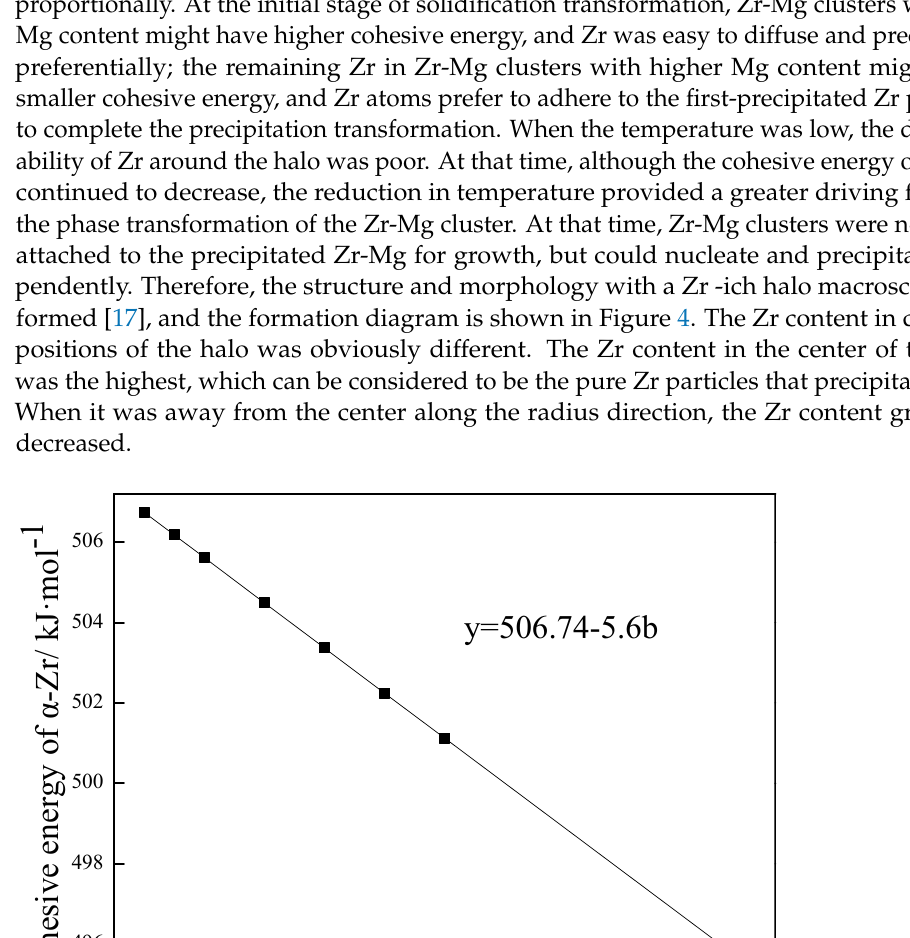
( c ) Figure 4. Schematic diagram of the formation of Zr-enriched halo structure in Mg–Zr alloy during solidification process ( a ) initial stage ( b ) intermediate stage ( c ) final stage. Through the previous analysis, we can conclude that it was precisely because of the formation of this special halo structure in the precipitation process that some Zr particles can become an effective heterogeneous nucleus of α -Mg. In the microstructure, this struc- ture of halo should be similar to the morphology of the double nucleation in an Al–Ti–B refiner, i.e., the two dimensional Al–Ti atomic layer was wrapped on the surface of TiB 2 particles. Generally, the structure and composition of the outermost surface of such parti- cles are the key factors to determine whether they can become a highly heterogeneous nucleus [16]. The outermost surface of the Zr–Mg halo structure must not be pure Zr at- oms, but a solid solution transitional layer composed of Zr–Mg with different Mg con- tents. The structure of this transitional layer is still close to a hexagonal structure, and the Mg atoms in the liquid phase can be effectively attached to this transitional layer for growth at the initial stage of nucleation. The schematic diagram of the formation of the Zr–Mg transitional layer on first-precipitated Zr is shown in Figure 5. The Zr–Mg transi- tional layer has two main functions. On the one hand, the formation of a Zr–Mg transi- tional layer on the surface of Zr particles is the inevitable result of the reduction in surface energy in the later stage of Zr growth. The formation of a Zr–Mg surface with relatively low energy renders the whole system more stable. On the other hand, the formation of a Zr–Mg structure actually means that Mg atoms in the liquid phase completed partial nu- cleation with the condition of the melt temperature being slightly higher than that of the